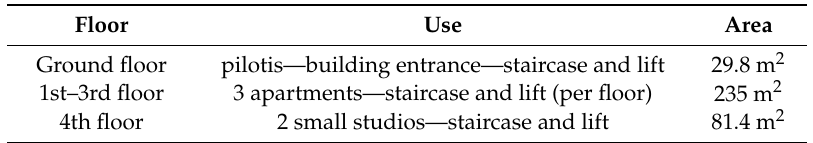
Table 2. Area distribution of the reference building per floor.